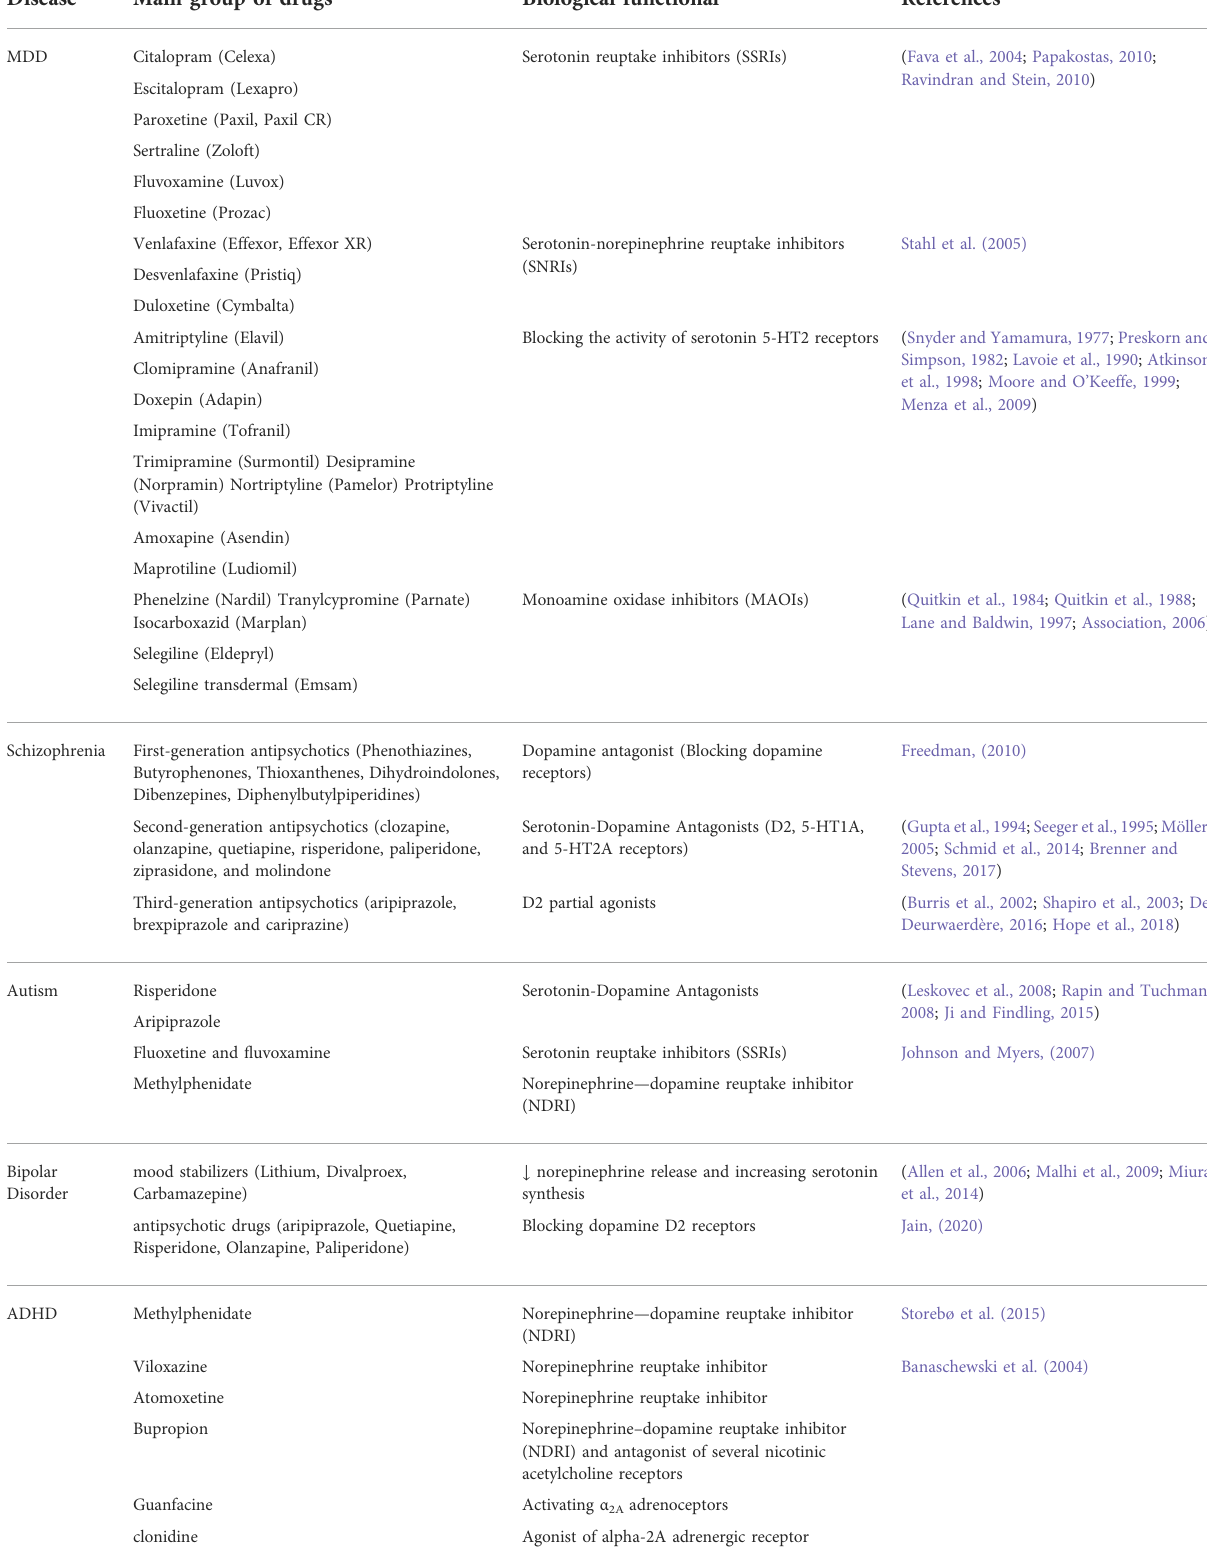
TABLE 1 Approved drugs and their biological function in the treatment of important neuropsychiatric